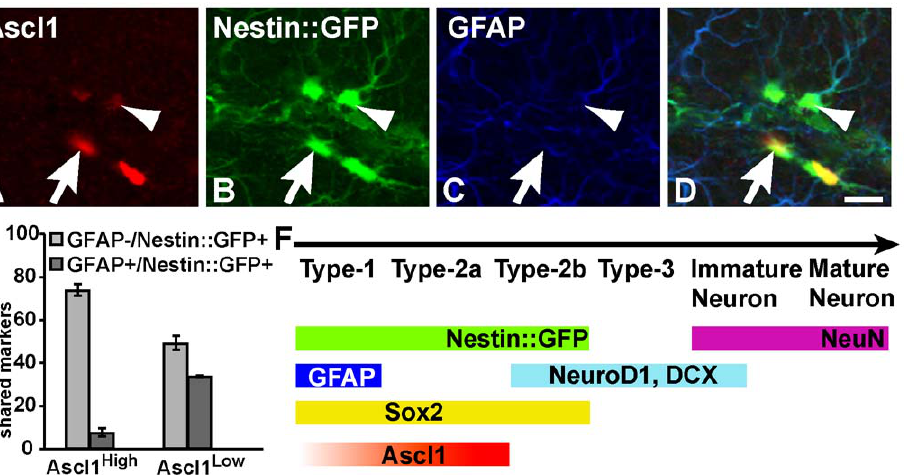
Figure 1. Ascl1 is present in a subpopulation of Type-1 stem cells and Type-2 progenitors in adult hippocampus. (A–D) Ascl1 is weakly detected in Nestin::GFP + GFAP + Type-1 stem cells (arrowhead) or strongly detected in Nestin::GFP + GFAP 2 Type-2 progenitors (arrow) in SGZ of adult Nestin::GFP mice. (E) Percentage of Ascl1 High or Ascl1 Low cells that express the markers Nestin::GFP and GFAP (Type-1) (dark shaded bars) or just the marker Nestin::GFP (Type-2) (grey shaded bars). 50 Ascl1 + cells were counted per mouse, n=3 Nestin::GFP mice. (F) Ascl1 is in Type-1 and early Type-2 cells based on a current model of adult hippocampal neurogenesis [14]. Scale bar =20 m m.